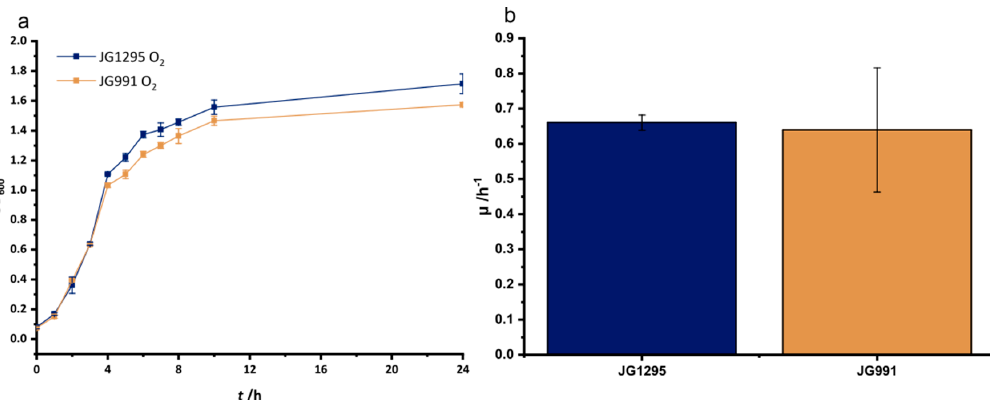
Figure 4. Aerobic growth in MOPS- Medium supplemented with 20 mmol/L glucose and 0.1% yeast extract. ( a ) Displayed are growth curves for the previous production strain (JG991) and the newly adapted strain (JG1295). The growth rates for this experiment are represented in ( b ). 3.2. The Adaptation to Growth on DMSO Is Based on Three Point Mutations